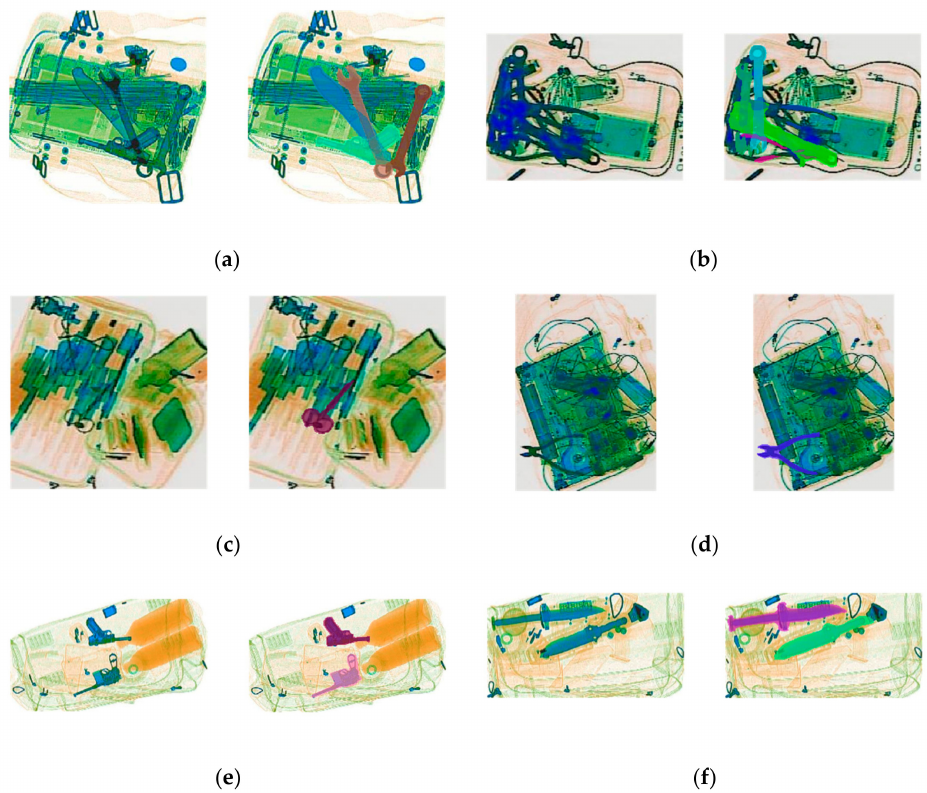
Figure 9. Exemplar images of verified detections. Images on the right are the inputs and images on the left are the outputs with overlayed masks. The examples range from overlapping threat objects, with ( a ) low densities and ( b ) high densities, to non-overlapping objects such as ( c ) scissors, ( d ) pliers, ( e ) guns, and ( f ) knives.